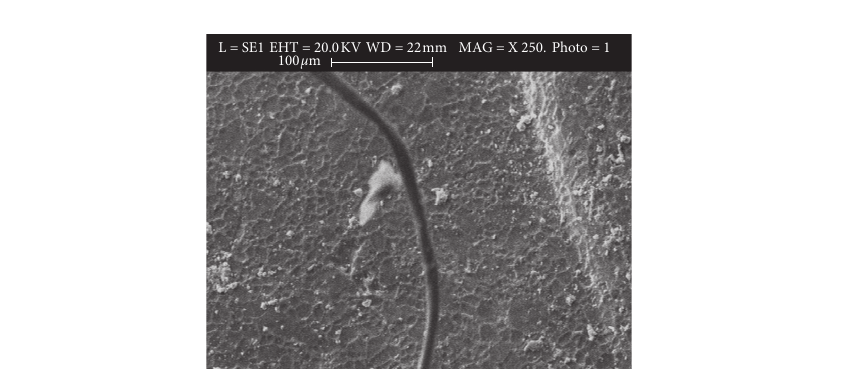
Figure 2: Electro-micrograph showing microporosities and micromechanical retention of adhesive remnants in US method.